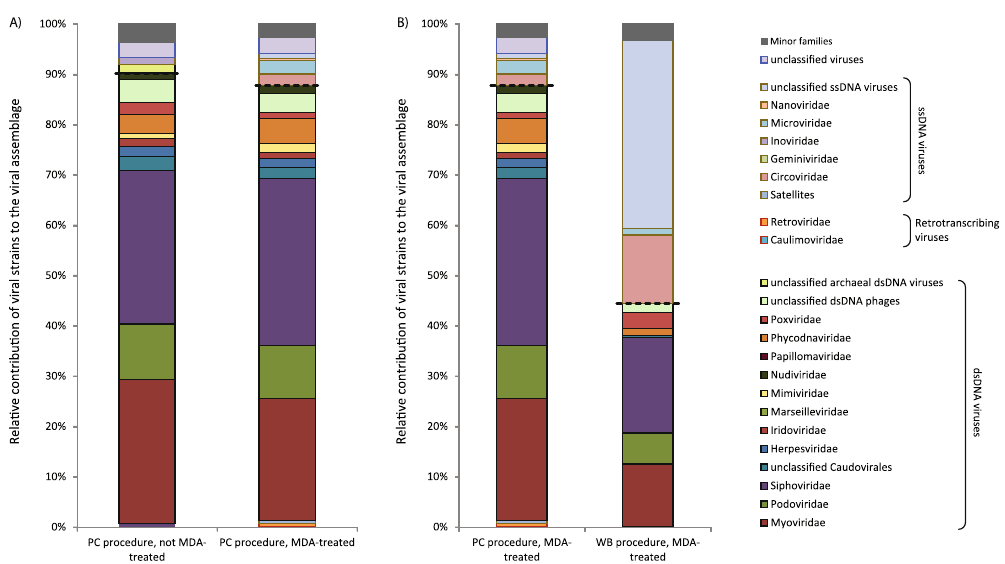
Figure 6. Comparison between the taxonomic composition of viromes of the Mediterranean Sea site generated in MDA-treated and un-treated samples ( A ) and by using WB and PC procedures ( B ). The taxonomic composition is expressed as the contribution of viral genotypes to the different viral families. Dashed lines were used to separate ssDNA and dsDNA viral